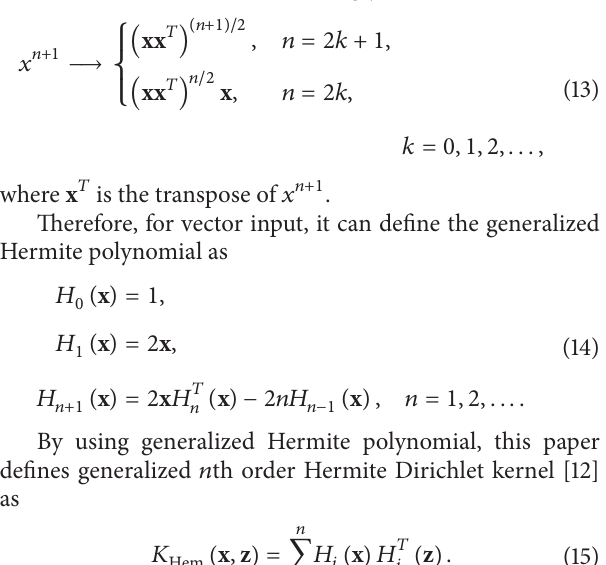
Figure 3: The graph of 𝐾 Gau ( x , z ) and 𝐾 Tri ( x , z ) , where 𝑧 = 0. 4.